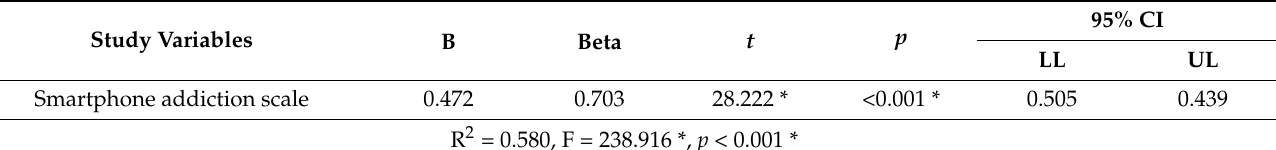
Table 5. Hierarchical linear regression (stepwise) of artificial